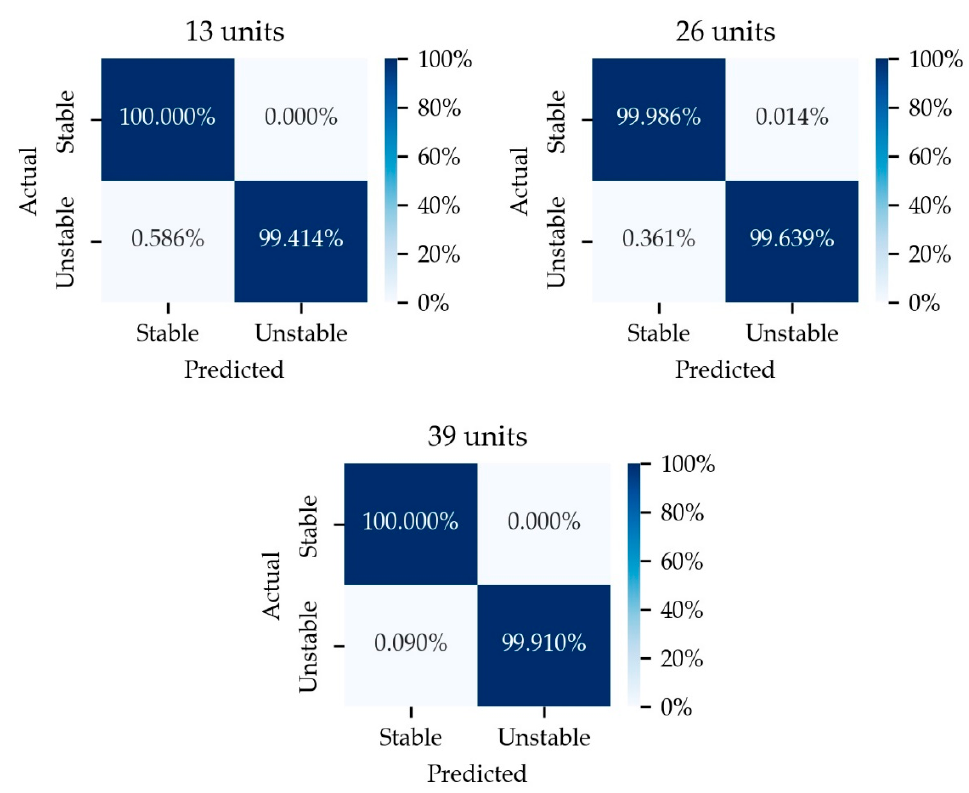
Figure 12. Recapitulation of normalized confusion matrix for the effect of the number of PMUs.